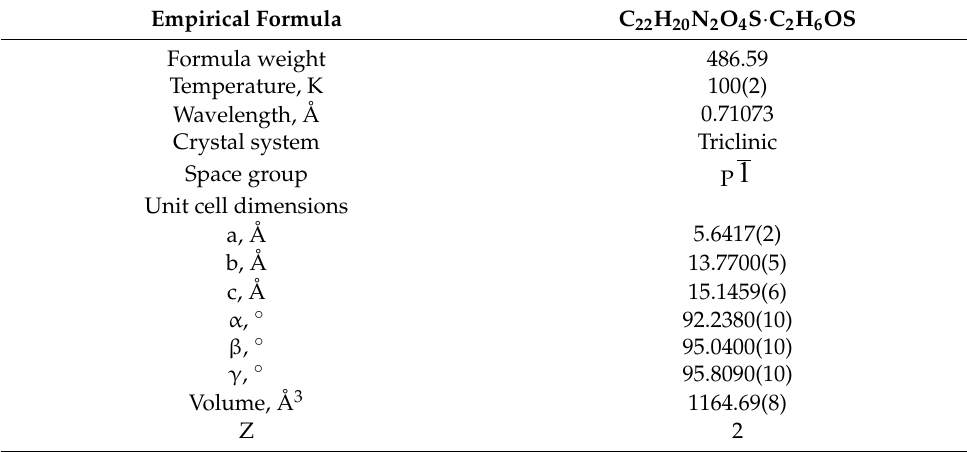
Table 2. Crystal data and structure refinement for 3b .